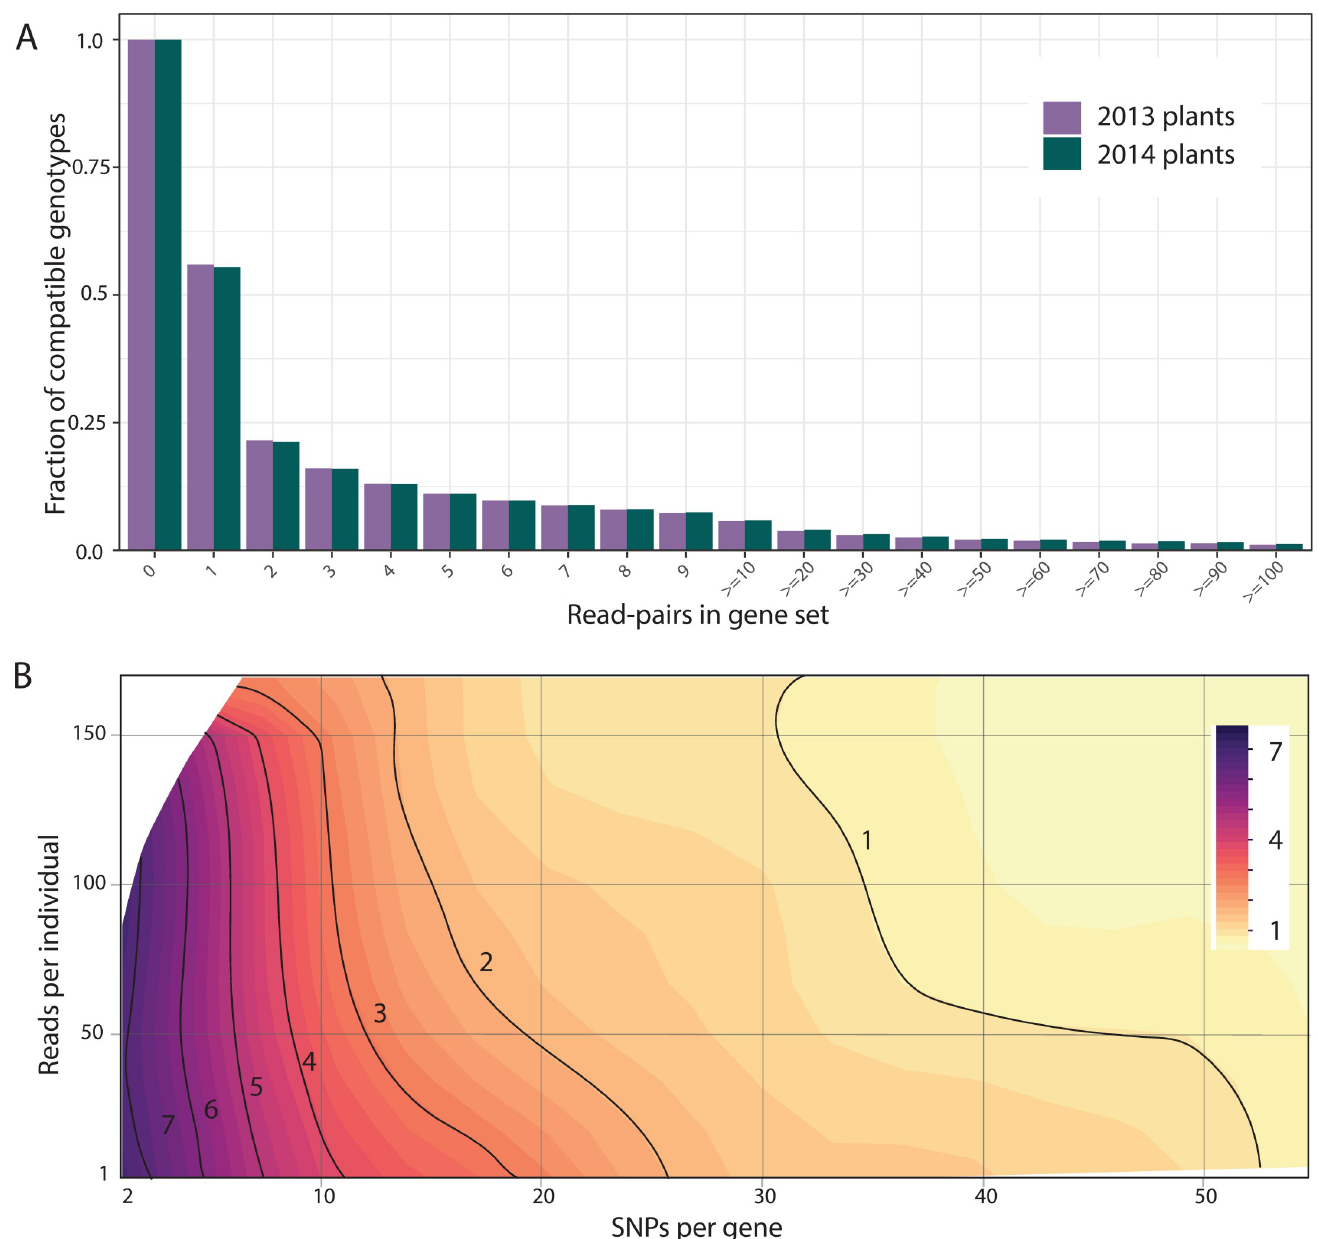
Fig 3. Testing haplotype matching: (A) In Mimulus, the precision of estimation is depicted as a function of the amount of data per plant. Compatible means that the likelihood for a genic-genotype is within 50% of the most likely genotype. (B) In Drosophila, the number of ancestors (indicated by contours and color) matching the genotype of a particular RIL is depicted as a function of amount of data (reads) and the number of SNPs in the gene set.